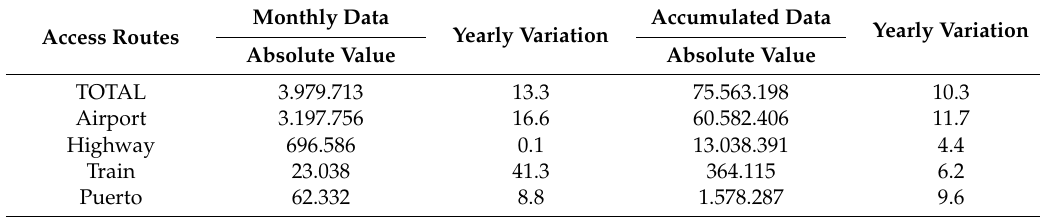
Table 3. Arrival of international tourists according to access